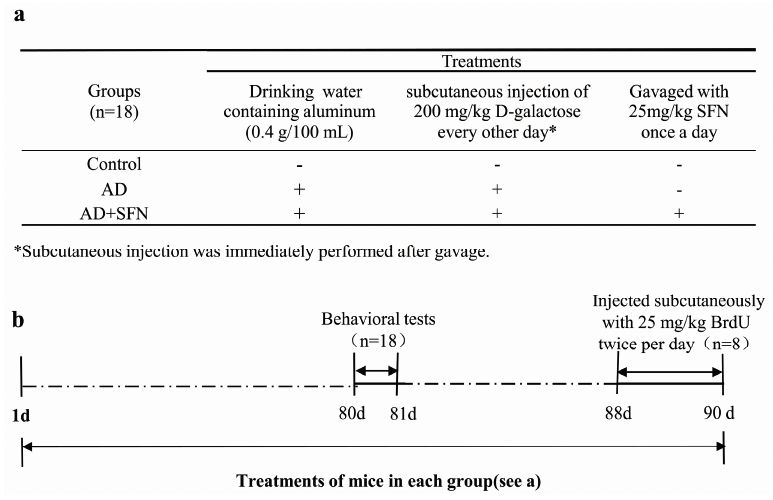
Figure 7. Scheme of animals groups and treatments. As shown in ( a ), mice were divided into 3 groups: control, AD-like and AD + SFN-like. Mice in groups of AD and AD + SFN were administered by the daily and free provision of drinking water containing aluminum (0.4 g/100 mL) and subcutaneous injection of 200 mg/kg D -galactose (dissolved in physiological saline) every other day. Distilled water and an equivalent amount of physiological saline were administered to mice in the control group as drinking water and by subcutaneous injection, respectively. Mice in the AD + SFN group were gavaged with 25 mg/kg sulforaphane (dissolved in distilled water) once a day, whereas mice in groups of AD and control were gavaged with an equivalent amount of distilled water; ( b ) shows that all mice were treated for 90 days. Behavioral tests were performed after 80 days of treatment. Three days before sacrifice, 25 mg/kg 5-Bromo-2'-deoxyuridine (BrdU) was subcutaneously injected twice per day to 8 mice in each